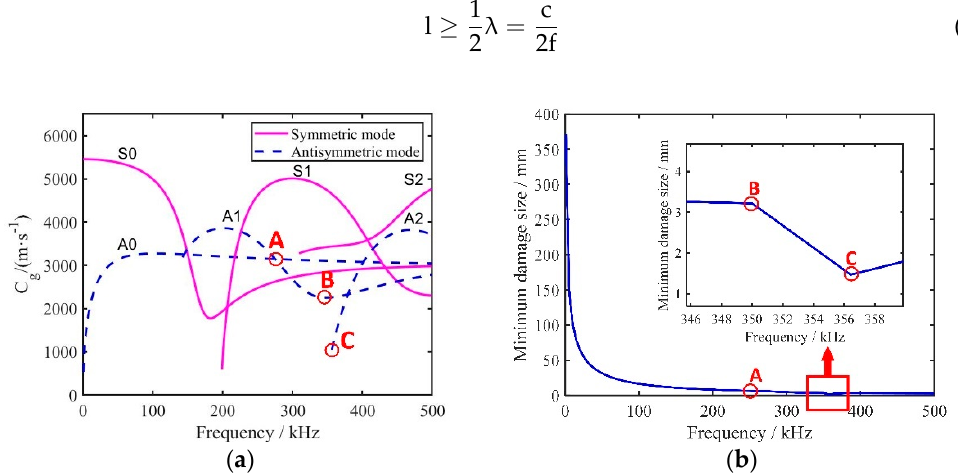
Figure 5. ( a ) Dispersion curve of rail bottom; ( b ) excitation frequency and minimum size of detectable damage.